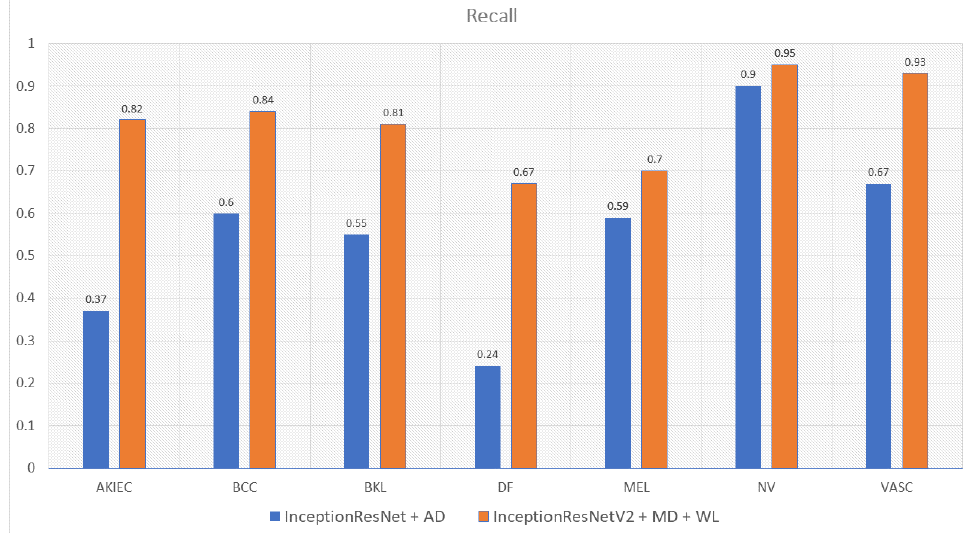
Figure 15. Comparison between recall of InceptionResNetV2 trained with augmented data and the one trained with metadata and weight